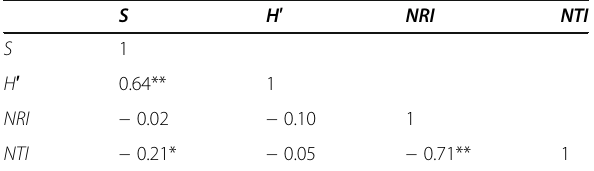
Table 1 Correlation matrix between species richness, Shannon- Weiner, net relatedness, and nearest taxon indices ( S , H ′ , NRI , and NTI , respectively). A single asterisk (*) indicates significant correlations ( p < 0.05), while double asterisks (**) indicate highly significant correlations ( p < 0.01)